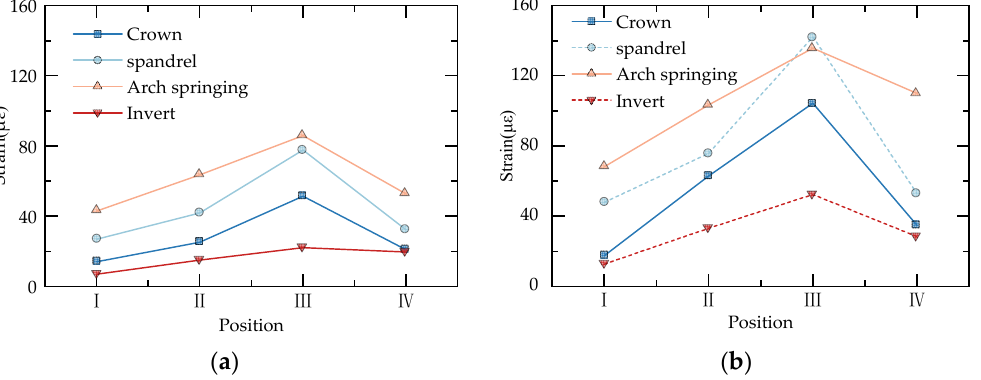
Figure 14. Peak strains of measuring points for excitations with different amplitudes. ( a ) 0.2 g; ( b ) 0.4 g.